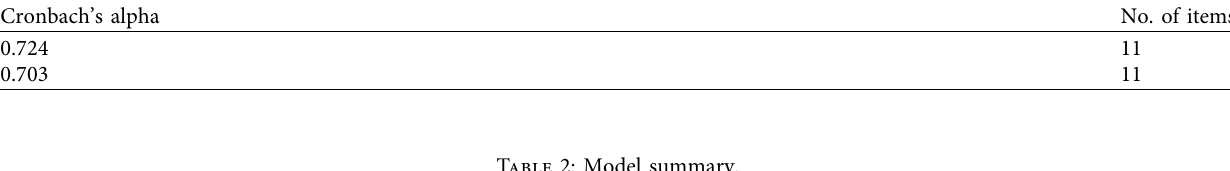
Table 1: Reliability test.